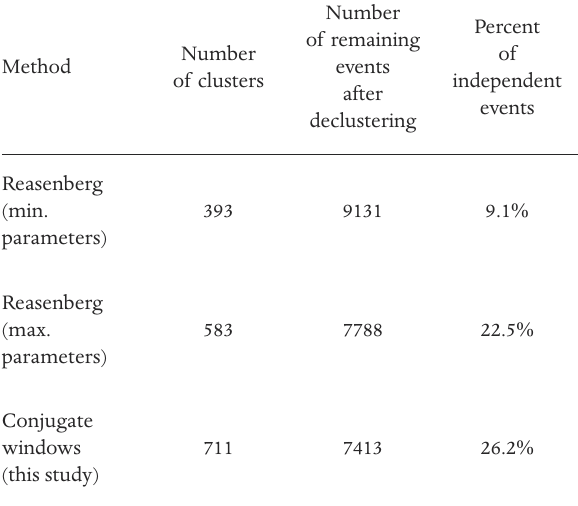
Table 9. Results of declustering the unified earthquake catalog of Iran containing 10,043 events. Minimum and maximum values